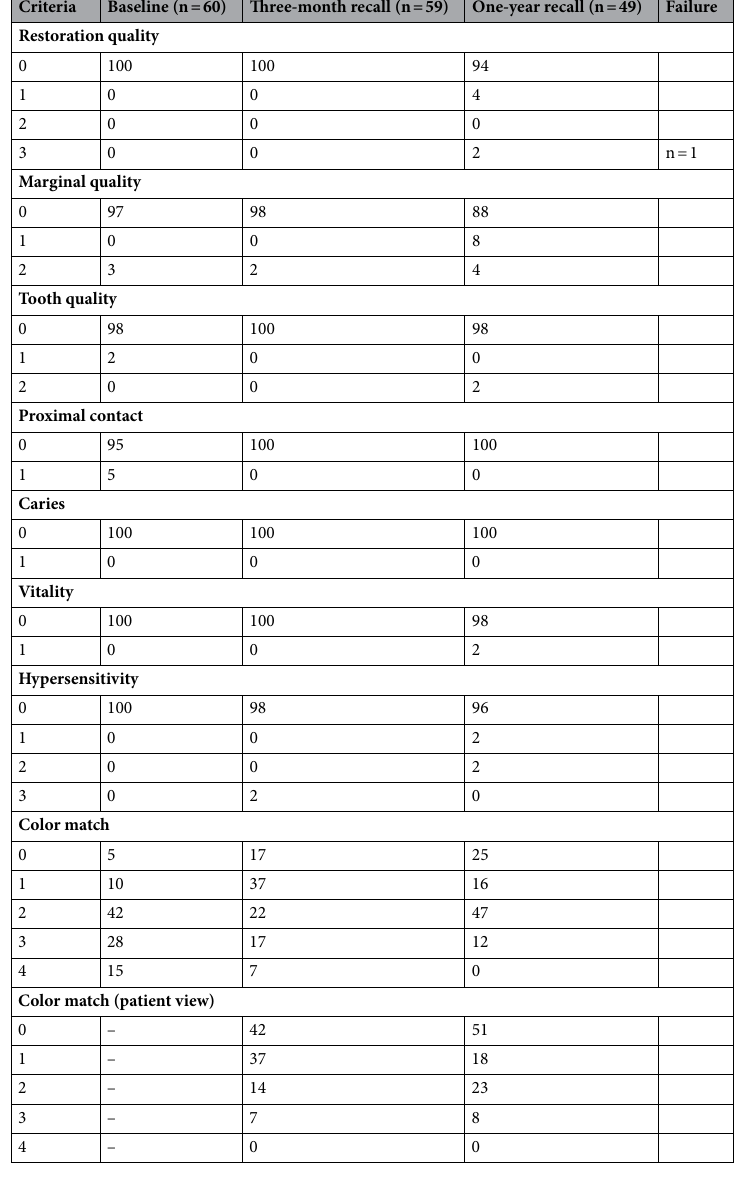
Table 4. Results (%) of the self-adhesive bulk-fill restorations evaluated at baseline and the follow-up visits. Significant changes over time were found for color match (P = 0.0002)—not